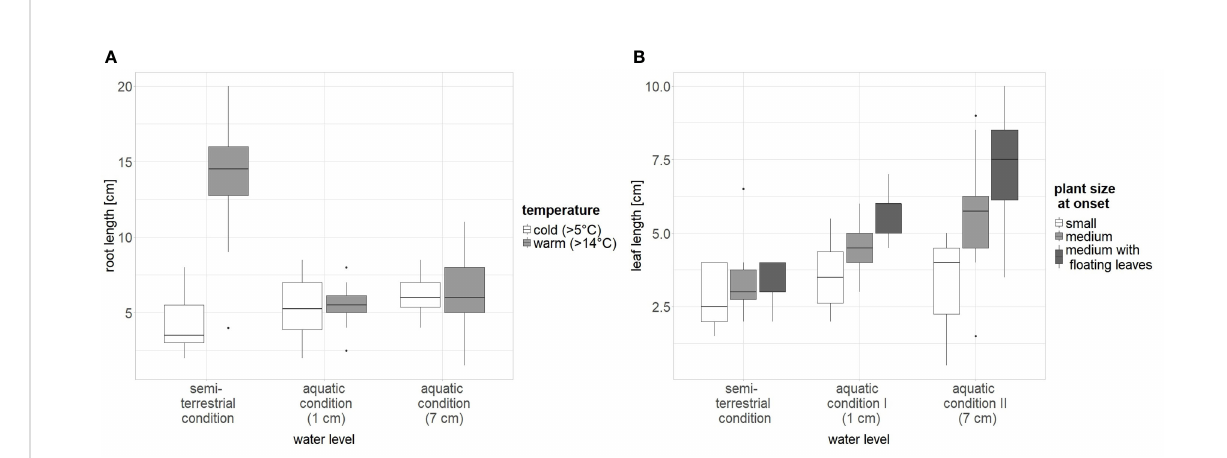
FIGURE 4 The in fl uence of signi fi cant factors on plant growth ( A : root length and B : leaf length) of L. natans . Water level: “ 1 cm ” : water about 0.5 − 1 cm above the rim of the pot; “ 7 cm ” : water about 7 cm above the rim of the pot; saturated: semi-terrestrial form, water only up to about 3 cm below the rim of the pot; temperature: cold ~ 5°C, warm ~